Question: Give a one-sentence summary of this figure.
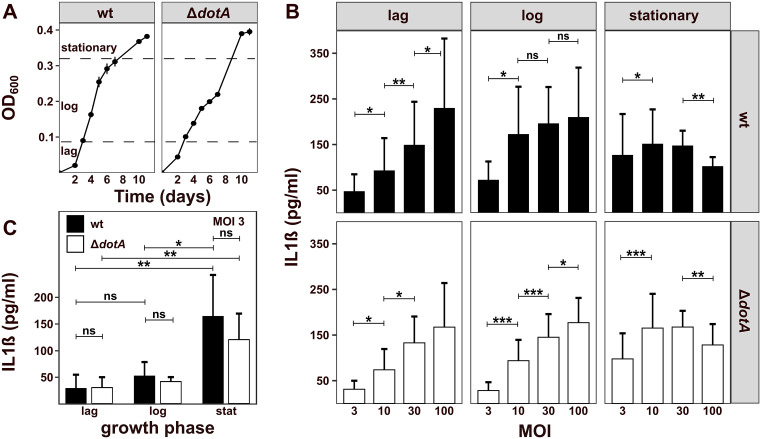
Answer: The induction of the inflammasome is dependent on the growth phase and MOI of C. burnetii. (A) The growth curves of the C. burnetii wt and Δ dotA strains were determined by culturing the bacteria for 12 days with regular measurement of the optical density at 600 nm (OD 600 ). (B) BMDM were infected for 32h with MOIs of 3, 10, 30 or 100 of the C. burnetii wt and Δ dotA strains grown to lag, log, and stationary growth phases. Secretion of IL1β was quantified by ELISA. (C) IL1β secretion was examined in murine BMDM infected at MOI 3 with C. burnetii wt and Δ dotA , which had been cultivated to the different growth phases. Mean ± SD, n = 3, t-test. ns = non significant, *p < 0.05, **p < 0.01, ***p < 0.001.